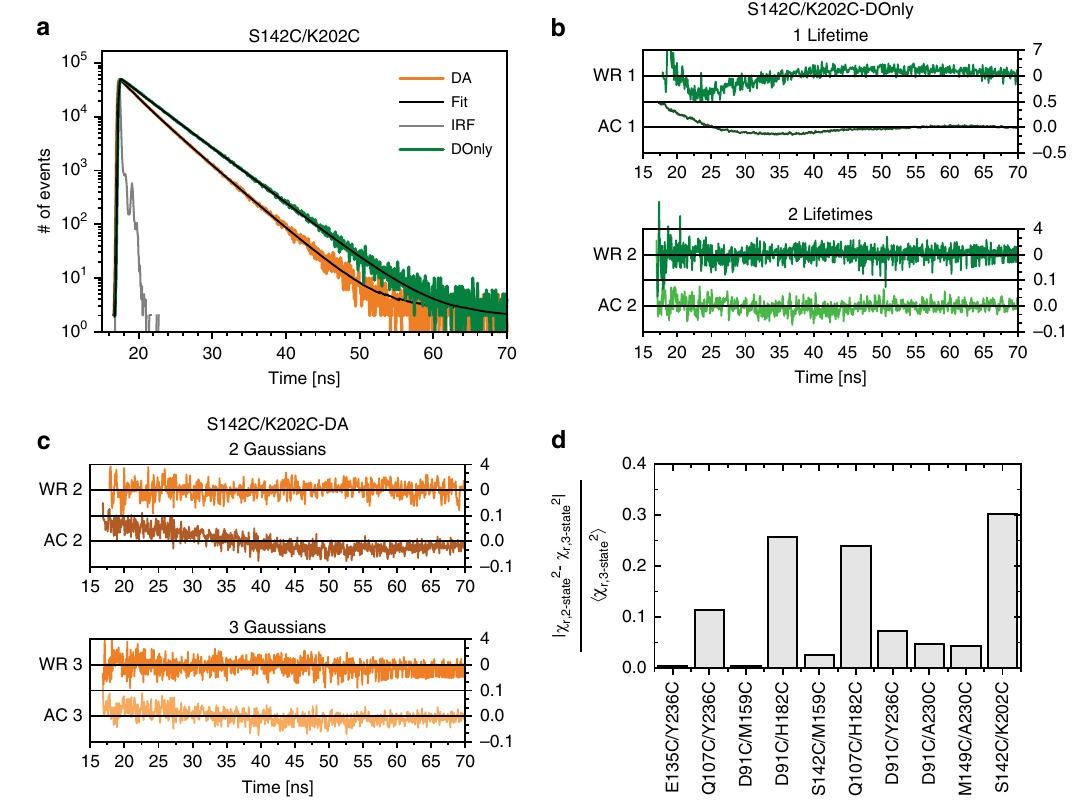
Fig. 2 Ensemble time correlated single photon counting (eTCSPC) to identify limiting states. Representative data are shown for the variant S142C/K202C. The remaining variants are shown in Supplementary Fig. 1. a Time-resolved fl uorescence decays for the Donor-only control (DOnly, green) and Donor- Acceptor FRET sample (DA, orange). Instrument response function is shown in gray. DA decays were fi t using a global analysis of all ten variants (black lines). b Weighted residuals (WR, green) and autocorrelation (AC, lighter green) for fi tting the DOnly decays with one (top panel) and two (bottom panel) fl uorescence lifetimes. c Weighted residuals (WR, orange) and autocorrelation (AC, brown and cream) for the global fi t using either two (top panel) or three (bottom panel) Gaussian-distributed states (Supplementary Table 1). d Improvement in χ 2 when fi tting with two or three Gaussian-distributed states. The relative change of χ 2 is shown for each FRET variant (labels beneath